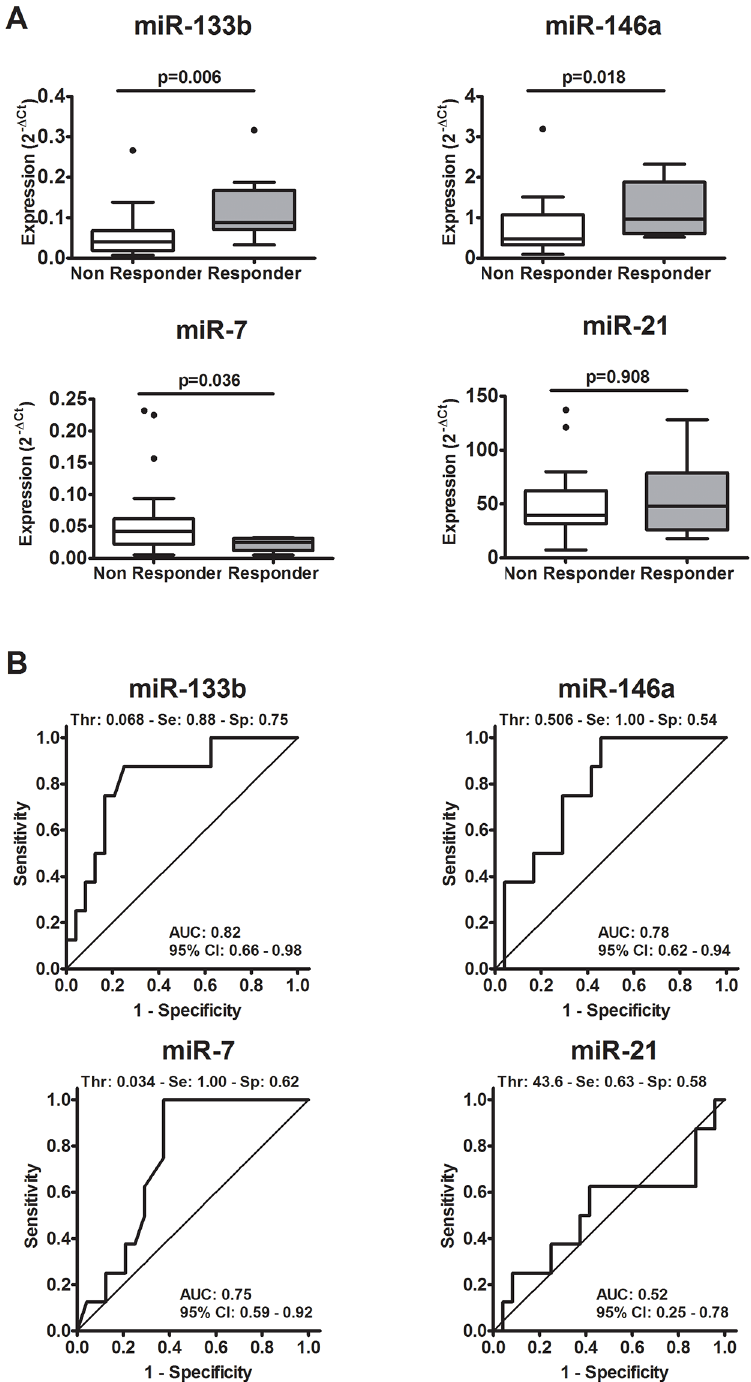
Fig 1. MiRNAs expression in relation to response to erlotinib. A Analysis of miRNA expression was investigated using TaqMan real-time quantitative PCR in NSCLC specimen from "responders" (n = 8) and "non-responders" patients (n = 24). Results are shown as normalized expression: 2 − Δ Ct compared with Mann-Whitney test. B ROC curve analysis of miRNA levels to predict response to erlotinib. AUC = Area Under the Curve; CI = Confidence Interval; Thr = Threshold; Se = Sensitivity; Sp =